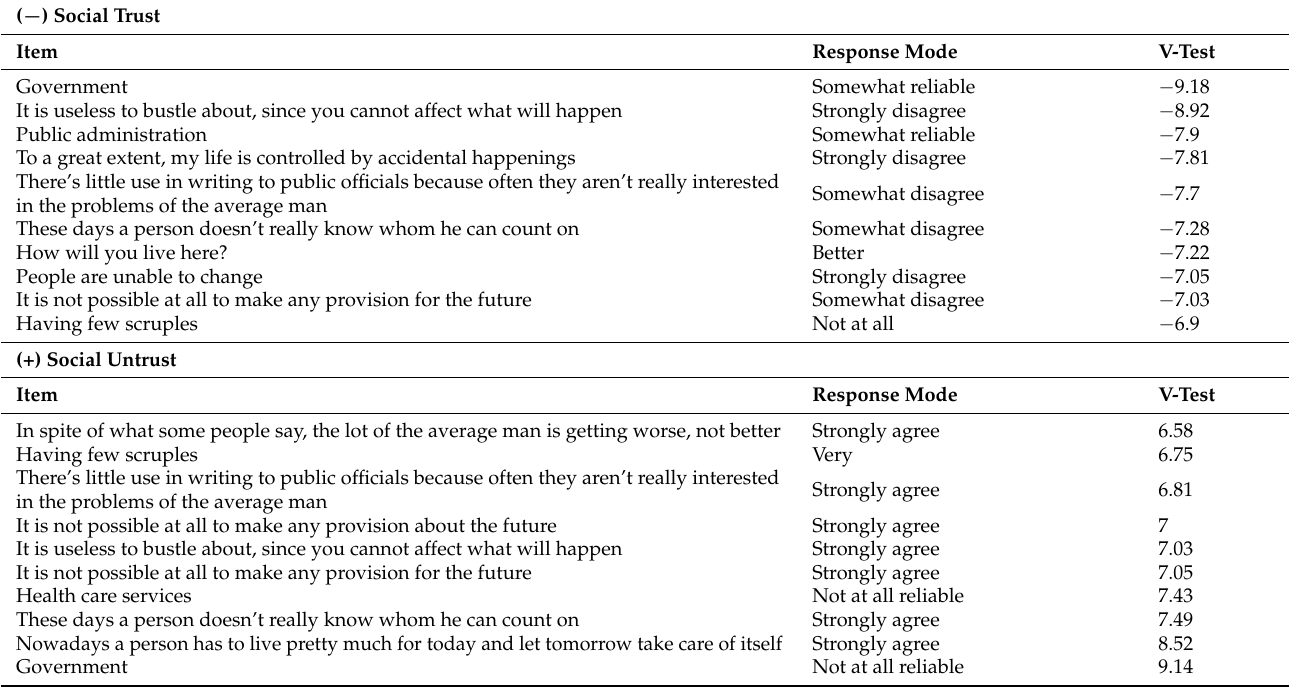
Table 1. Response modalities associated with the first factorial dimension (VOC